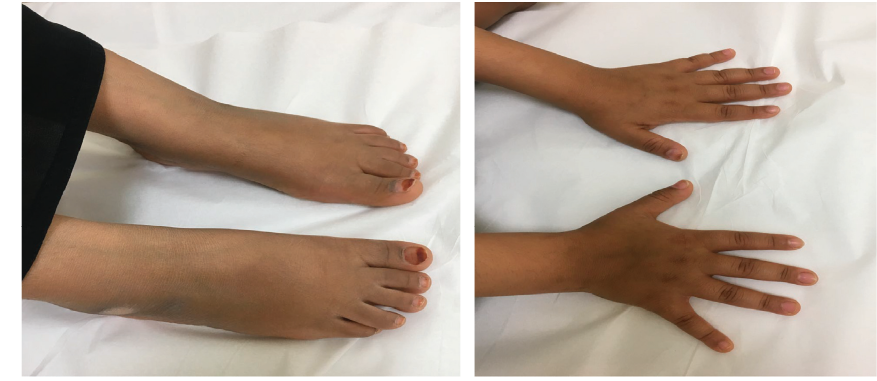
Figure 1: Photographs showing edema of both hands and feet.